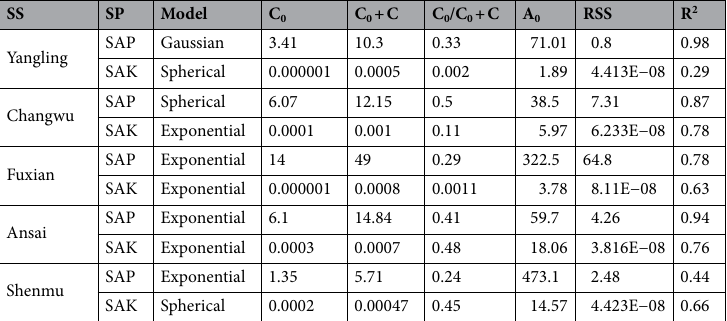
Table 4. Spatial structure parameters of soil available phosphorus (SAP) and soil available potassium (SAK) for the sampling sites. SS sampling sites, SP structure parameters, C 0 nugget, C 0 + C sill, C 0 /(C 0 + C) anisotropy ratio, A 0 range, RSS residual sum of squares, R 2 coefficient of